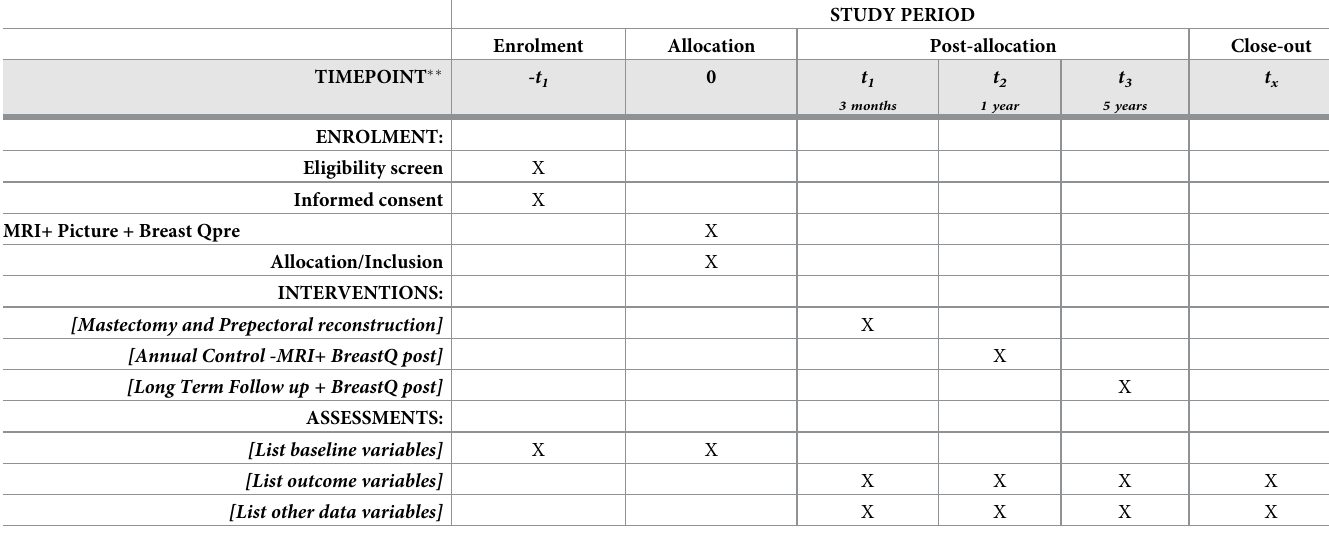
Table 1. Schedule for patient assessment in the PreQ-20